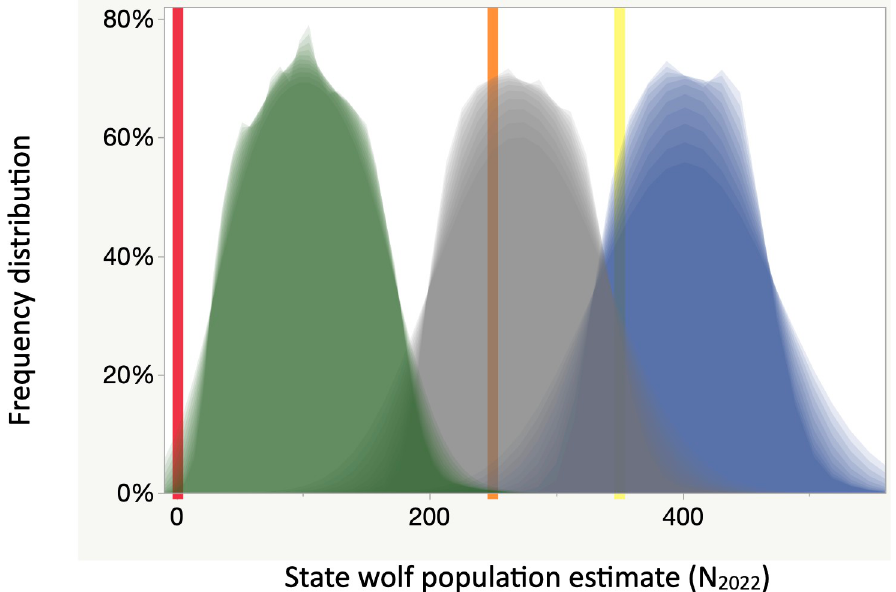
Fig 4. Distributions of predicted population estimates for Wisconsin’s wolves on 14 April 2022. Frequency distributions assume death tolls of 300 (green), 130 (gray), and 0 (blue) relative to reference lines of extirpation (red), listing (orange), and population goal (yellow). We ran 3600 iterations to generate smoother probability distributions as “shadow grams” made in JMP 1 15.0, 2021, for each value of H. These distributions rely on the traditional census method (Fig 3A) and average and SD follow: (green) 61 SD 44 with a 9% chance of extirpation and 100% chance of dropping below the state listing threshold, (gray) 231 SD 45 with a > 99.5% chance of dropping below the state population goal and a 64% chance of dropping below the state listing threshold, (blue) 361 SFD 44 with a 13% chance of falling below the state population goal.